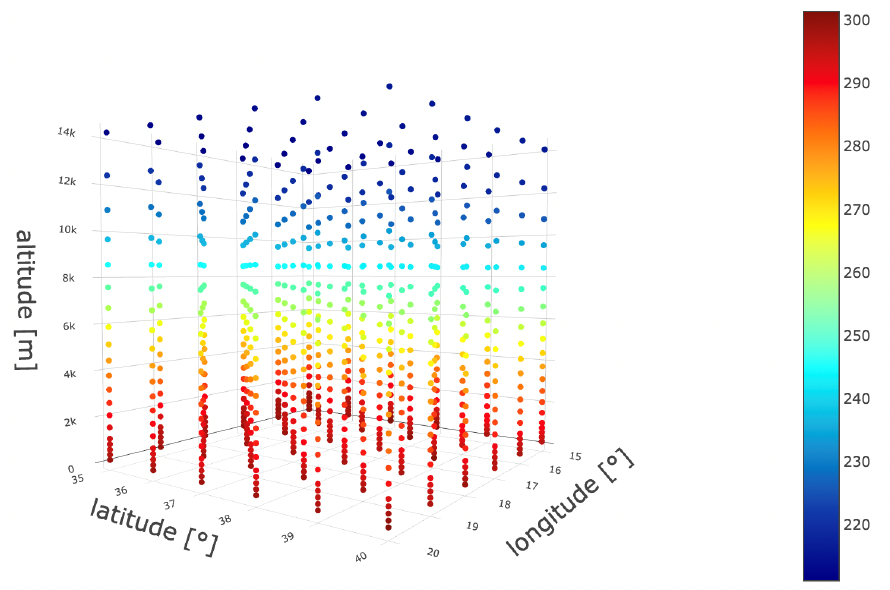
Figure 2. A snapshot of temperature (in Kelvin) with GFS data on 4th of September 2018 and longitude ranges from 15E to 20E, latitude from 35N to